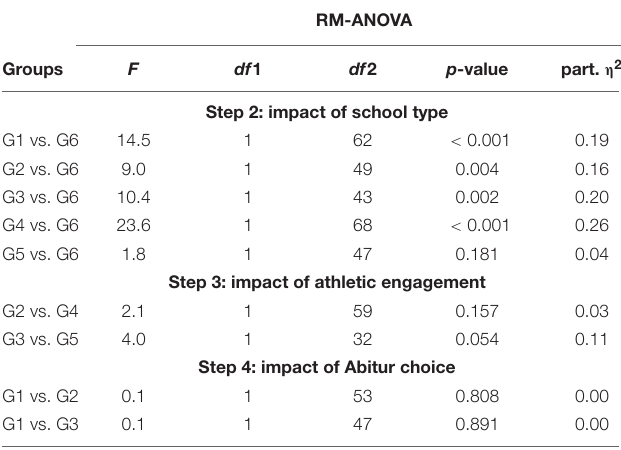
TABLE 5 | Extract of Supplementary Tables 2–10 in the electronic supplements presenting the post hoc two group interaction effects (Group × Time) of the RM-ANOVAs for the total score in the English